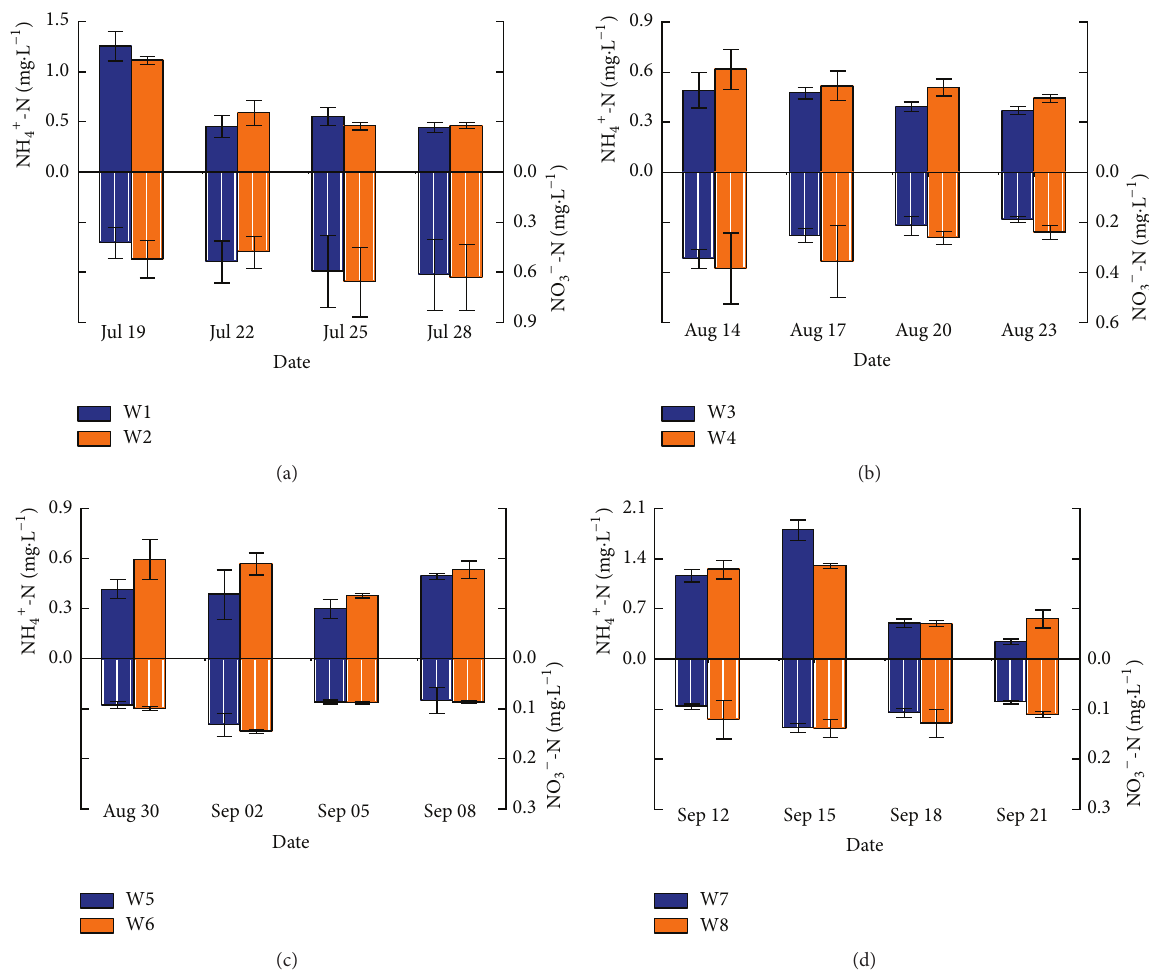
Figure 3: Dynamic changes of NH 4+ -N and NO 3− -N concentration in subsurface water. (a) Tillering stage. (b) Jointing-booting stage. (c) Heading-flowering stage. (d) Milking